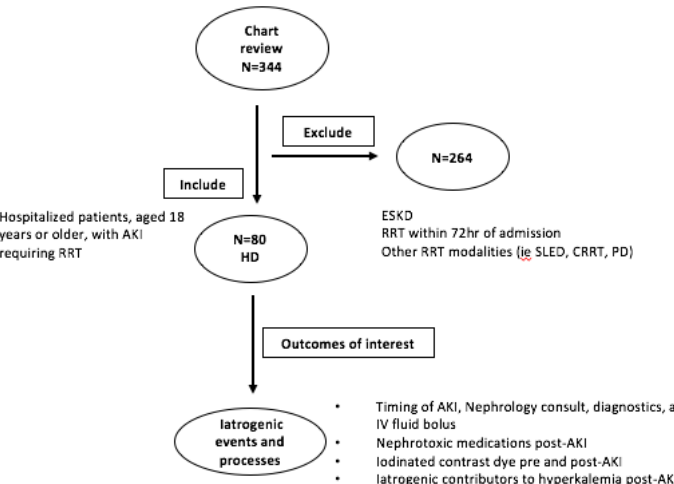
Figure 1. Summary of study design for this retrospective chart review. A total of 344 electronic inpatient records were reviewed, and 80 consecutive hospitalized patients meeting inclusion criteria were included. Data was collected for qualitative assessment of iatrogenic events and processes that may have contributed to the need for RRT (in the form of HD) for AKI. AKI, acute kidney injury; RRT, renal replacement therapy; HD, intermittent hemodialysis; ESKD, end-stage kidney disease; SLED, slow low efficiency dialysis; PD, peritoneal dialysis.